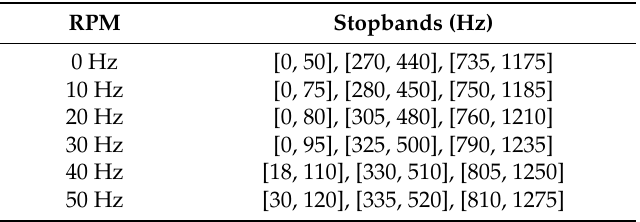
Table 8. Experimental stopbands derived from different rotating